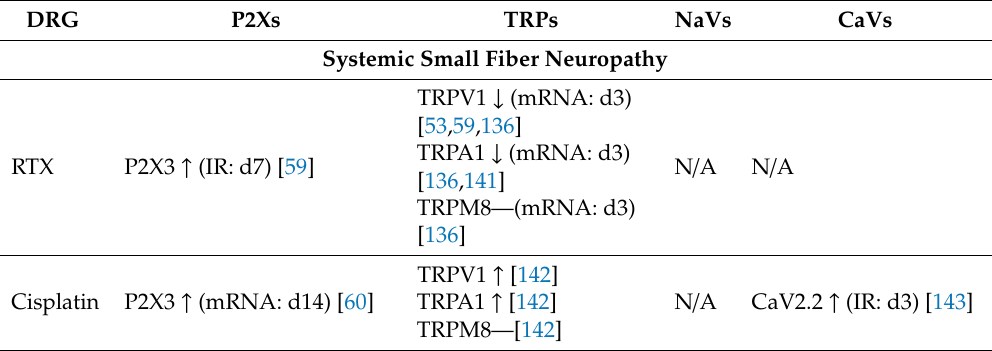
Table 3. Molecular mediators of neuropathic pain in systemic small fiber neuropathy